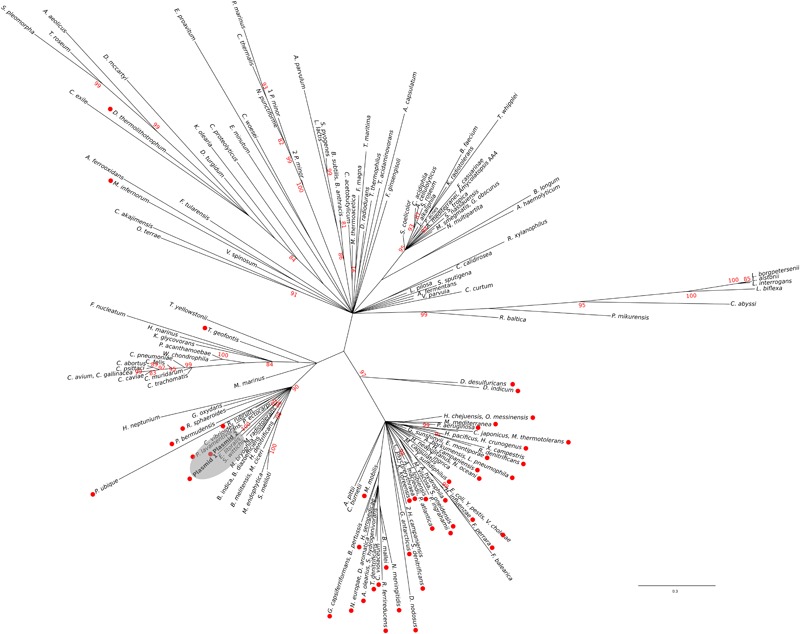
Consensus tree of N-terminal GlmM protein sequences. Branch support values are provided as Bayesian posterior probabilities. For clarity, only posterior probability values higher than 0.8 are displayed. The placement of sul2-encoded proteins is indicated by a shaded ellipse.